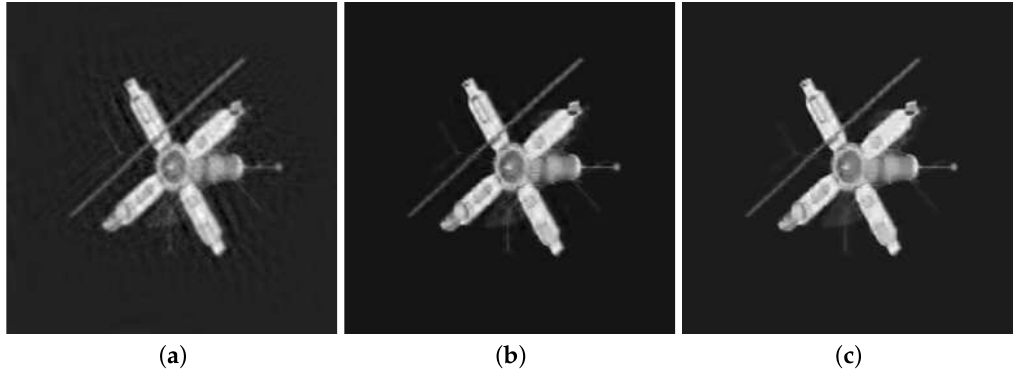
Figure 8. Satellite test problem reconstructions: ( a ) AIT-GP, ( b ) PISTA h , ( c ) Struct-PISTA h . Table 1. Comparison of the quality of the reconstructions for all considered examples. We highlight in boldface the best